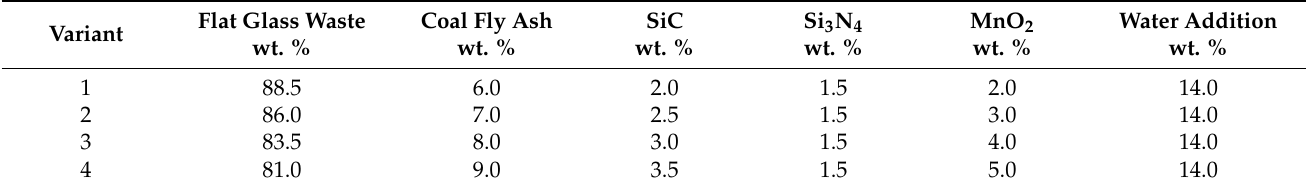
Table 2. Experimental variants